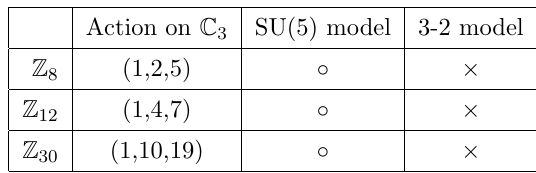
dimer with orientifold 8